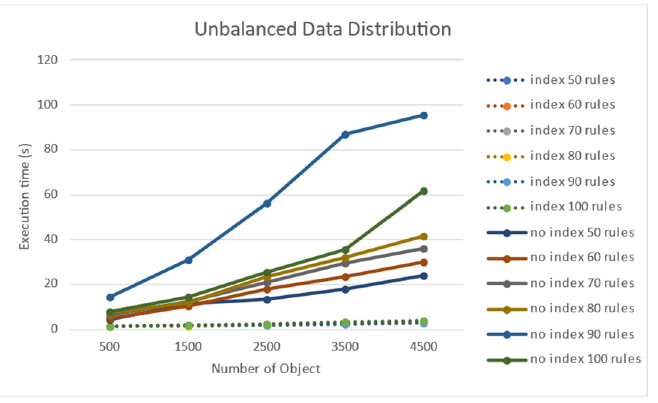
Figure 9. Performance effect of the number of objects on a non-uniform object distribution.